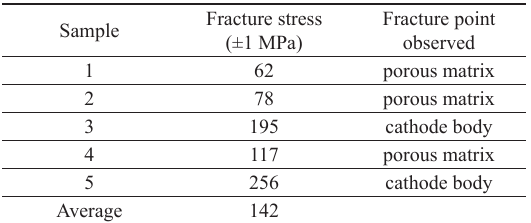
Table 7. Strength test results from 5 cathode samples brazed at 1967°C. Sample